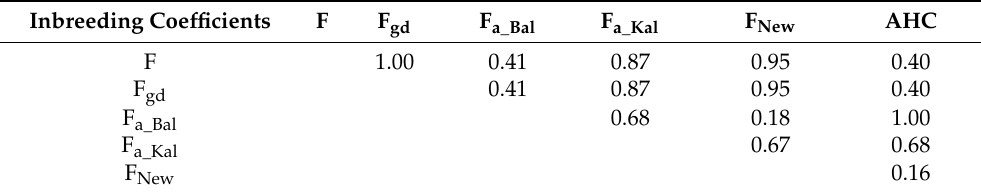
Table 4. Pearson correlation coefficients between inbreeding coefficient according to Meuwissen and Luo (F), individual inbreeding using the genedrop method (F gd ), ancestral inbreeding according to Ballou (F a_Bal ) and Kalinowski et al. (F a_Kal ), new inbreeding according to Kalinowski (F New ) and ancestral history coefficient according to Baumung et al. (AHC) for Deutsch Drahthaar dogs born from 2000 to 2020. p -values of all correlation coefficients were <0.0001. Inbreeding Coefficients F F gd F a_Bal F a_Kal